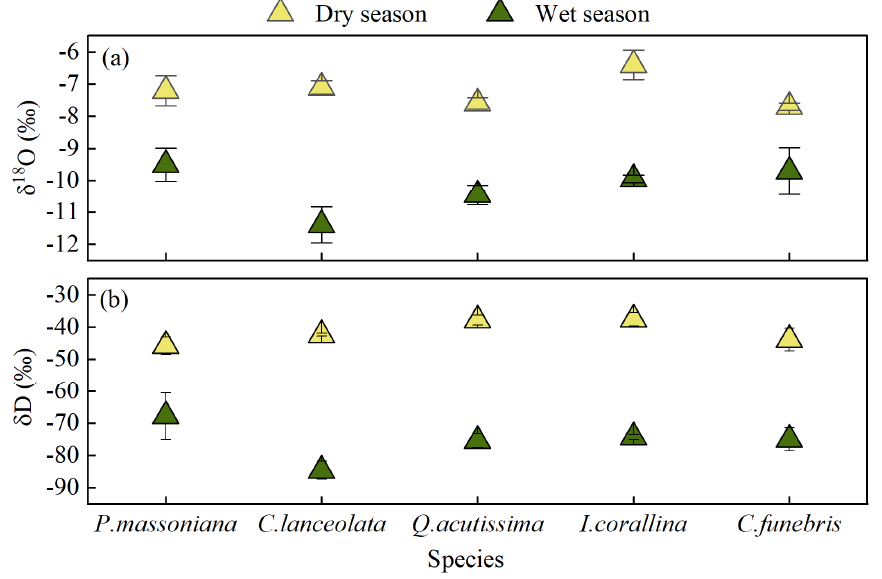
Figure 7. Seasonal isotopic variations of ( a ) 𝛿𝐷 and ( b ) 𝛿 (cid:2869)(cid:2876) 𝑂 xylem water in P. massoniana, C. lan- ceolata, Q. acutissima, I. corallina and C. funebris. Error bars represent the standard deviation ( N =